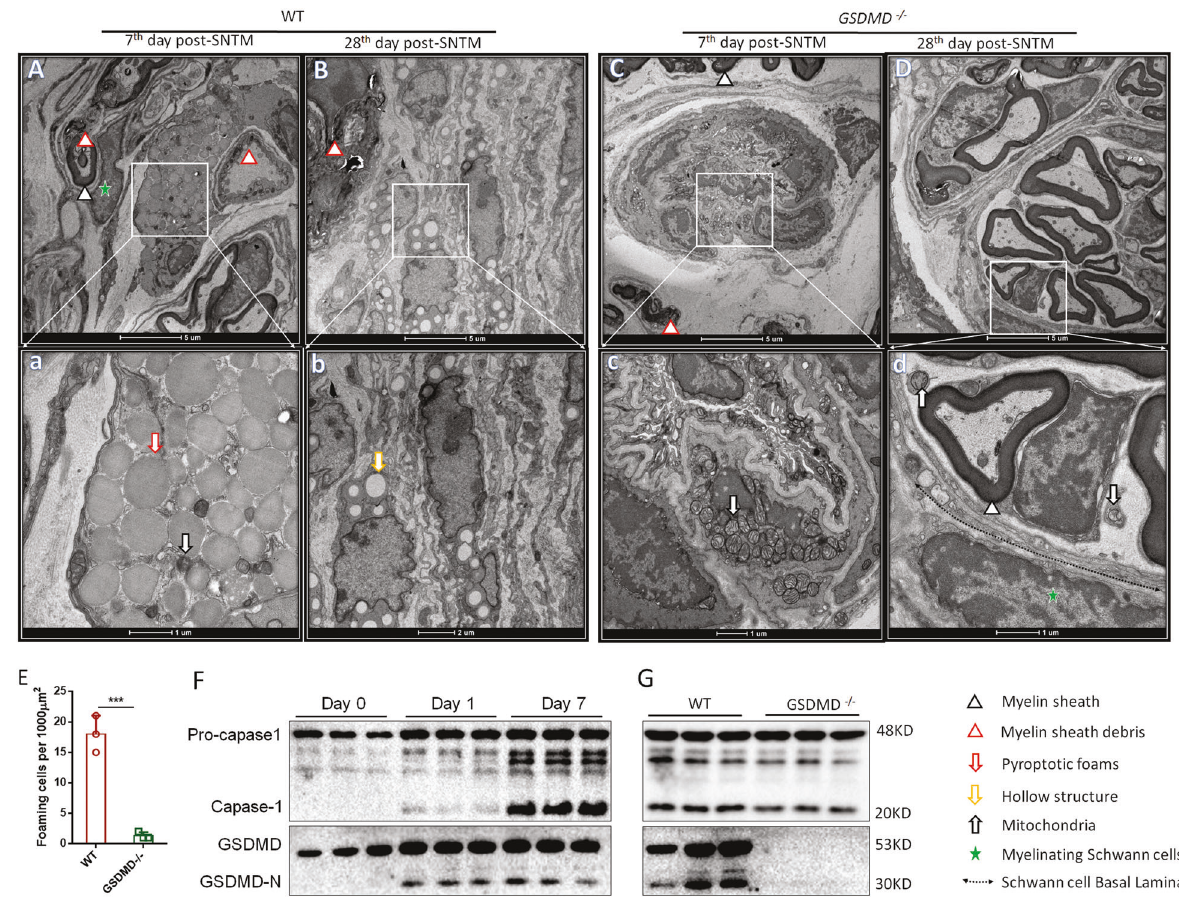
Fig. 1 GSDMD de fi ciency resulted in reduced pyroptotic foaming cells and decreased caspase-1 in the SNTM bridge. A In the bridge of the WT SNTM group, foaming macrophages underwent pyroptosis near the degenerating myelin sheath, and several enlarged swollen mitochondria were found near these foams (a) on the 7th day post-surgery. B On the 28th day, these pyroptotic foams turned into vacuole structures after releasing their in fl ammatory contents, the vacuole structures (b) were near the remnant nuclei, and they were surrounded by sheath debris and fi brotic and necrotic structures, whereas few regenerated nerve sheaths and axons were found. C In the bridge of the GSDMD − / − SNTM group, several in fi ltrating macrophages were found near the degenerating myelin sheath. These macrophages died without foaming. Many swollen mitochondria were found near the remnant nuclei. (c) On the 7th day post-surgery. D On the 28th day, the GSDMD − / − SNTM group showed regenerated myelin sheaths and axons, and depolarized Schwann cells had formed the Büngner band, where a few dead mitochondria were found. E GSDMD − / − mice demonstrated signi fi cantly decreased foaming cells in the SNTM bridge, compared to their WT control (*** p < 0.0001; n = 3). F The dynamic expression of caspase-1 and GSDMD-N (cleaved by pro-caspase-1 and GSDMD, respectively) in the WT SNTM (on day 0, day 1, and day 7) suggested the occurrence of GSDMD-N executed pyroptosis, with particular signi fi cance on the 7th day ( n = 3). G GSDMD − / − SNTM had decreased cleaved caspase-1 expression and de fi ciency of GSDMD and GSDMD-N expression, compared to their WT SNTM on the 7th day post-operation ( n =